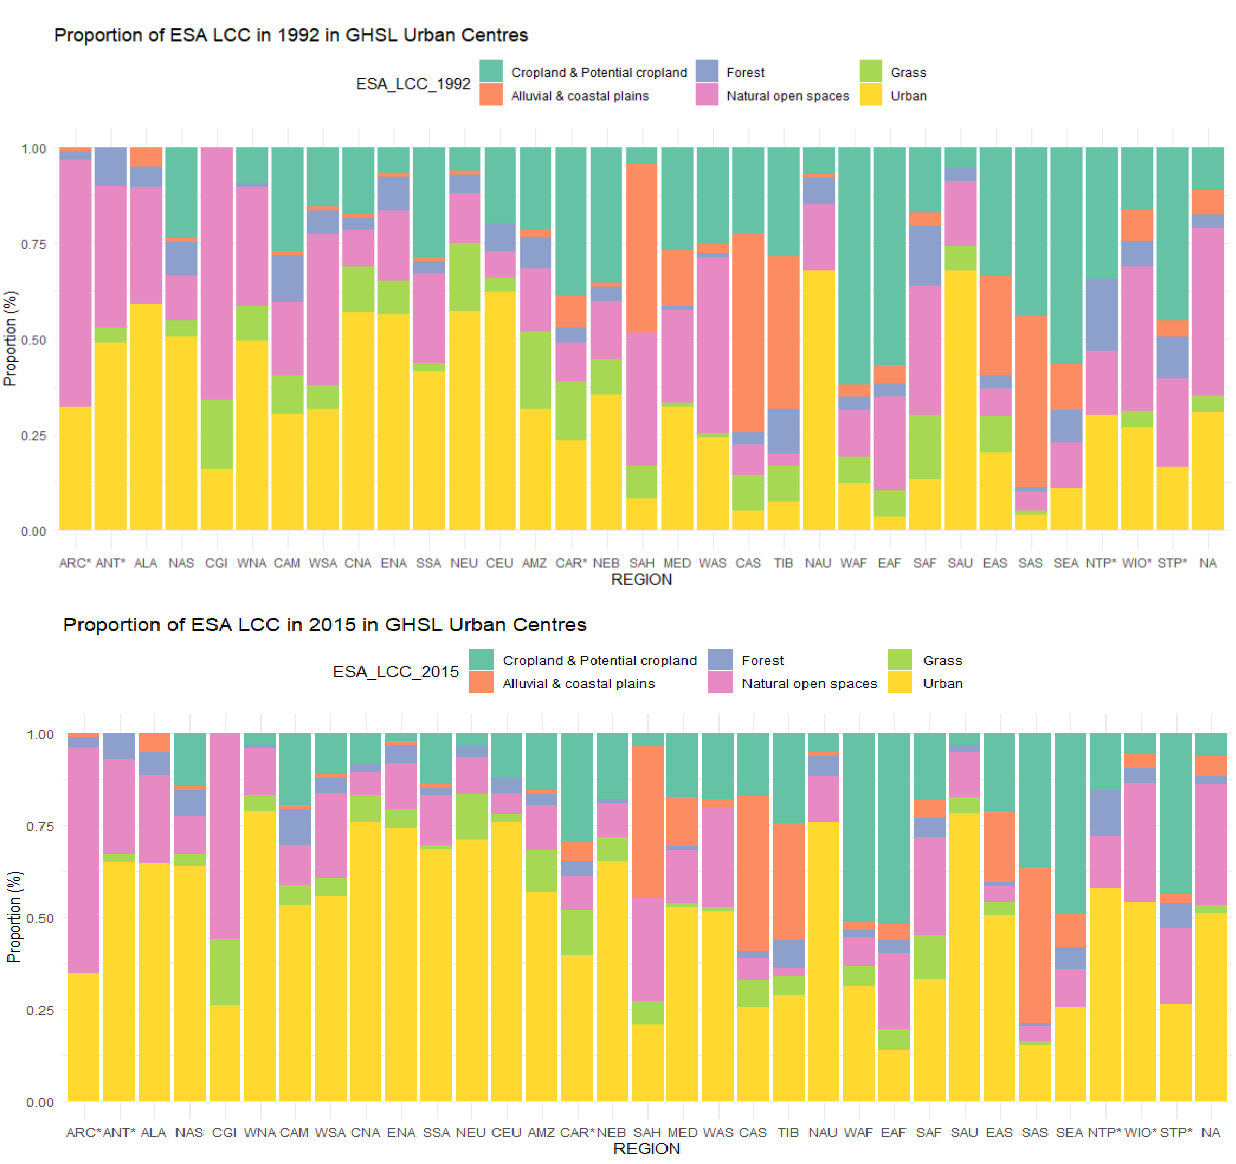
Figure 5. Landcover changes in urban